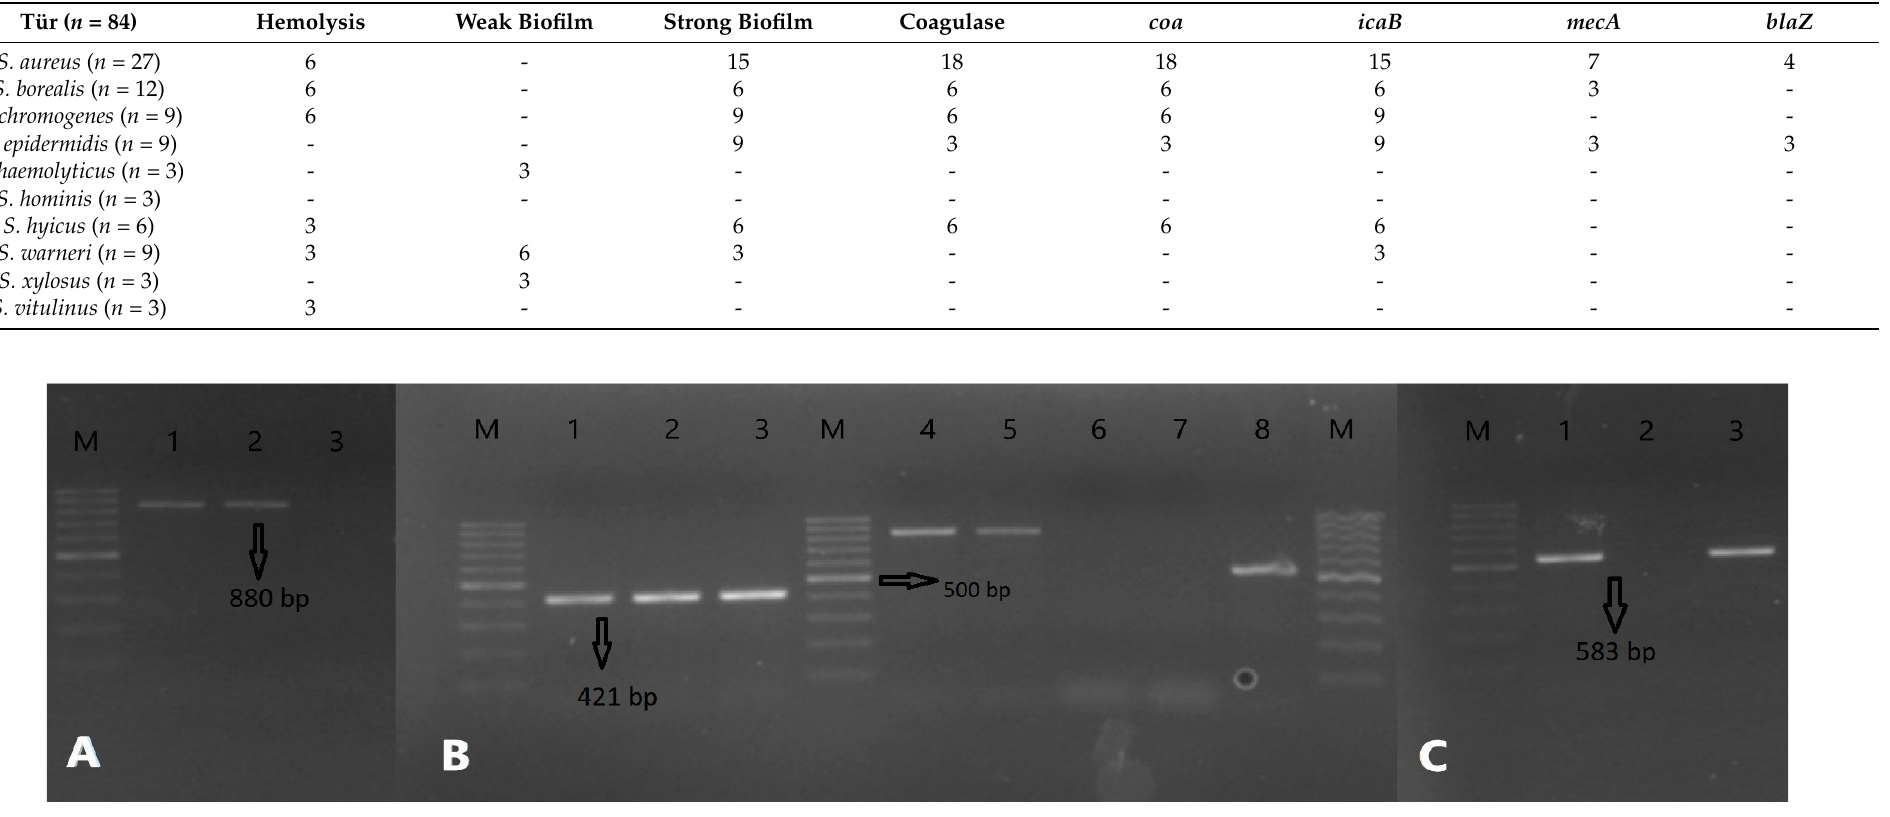
Figure 6. PCR results: ( A ) PCR bands for icaB (880 bp), 1,2: Positive sample, 3: Negative sample. ( B ) PCR bands for blaZ (421 bp) and coa (variable), 1: Positive control for blaZ , 2,3: Positive samples for blaZ , which is from the S. aureus strains, 4,5: Positive result for coa is almost 850 bp, 6,7: Negative samples, 8: Positive result for coa is almost 550 bp. ( C ) PCR bands for mecA (583 bp), 1,3: Positive samples for mecA , which is from the S. epidermidis strains, 2: Negative sample. M: Marker, 100–1000 bp DNA ladder is used.